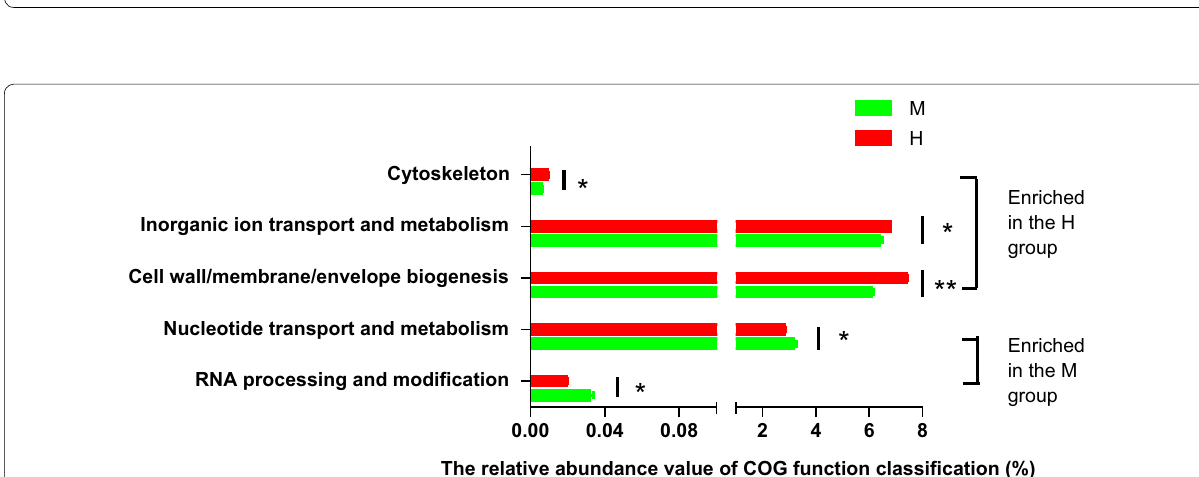
Fig. 3 COG function classification in the microbiota of the intestinal tract samples. M: midgut (green), H: hindgut (red). 0.01 < P 0.001 < P ≤